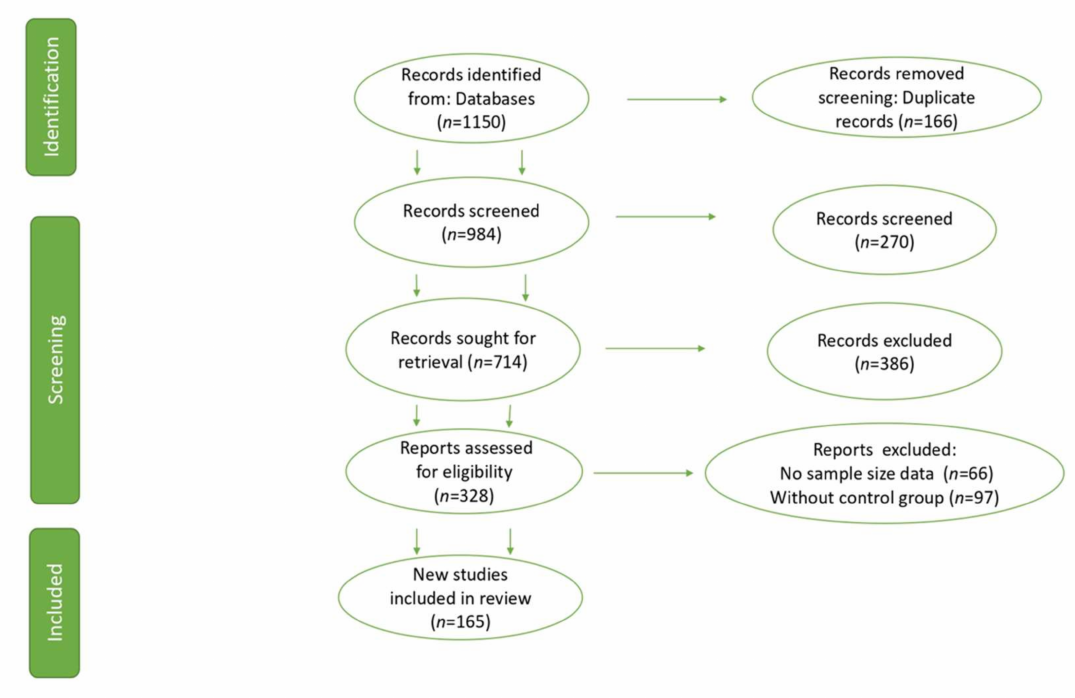
Figure 1. PRISMA study flow diagram of the systematic review from the initial search and screening to the final selection of publications to be included in the systematic